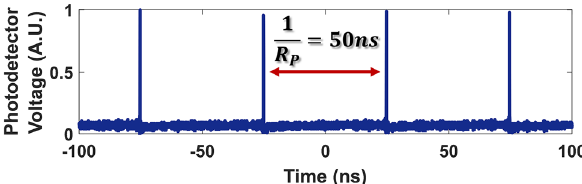
Figure 5: Oscilloscope measurements showing the pulse train generation from the CW signal occurring every 50 ns, corresponding to the repetition rate of the pump